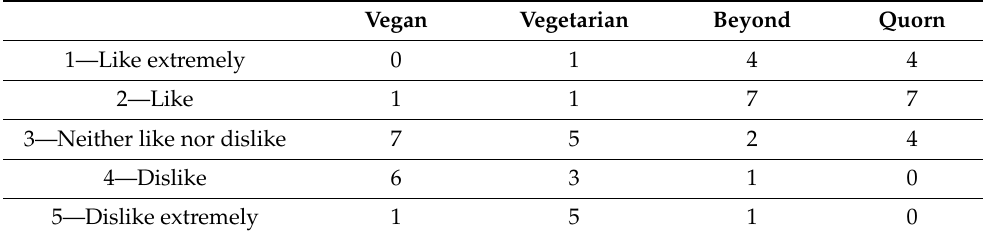
Table 3. Preference profiles regarding texture across the participants ( n =